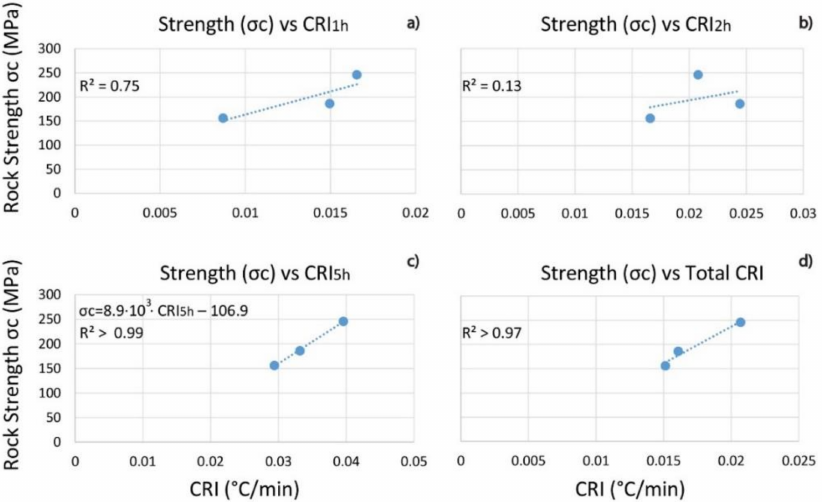
Figure 7. Linear regression analysis between rock strength ( σ c ) and CRI according to different time intervals since the beginning of cooling: ( a ) 1 h; ( b ) 2 h; ( c ) 5 h; ( d ) entire cooling phase. The markers represent the mean values for blocks A, B and